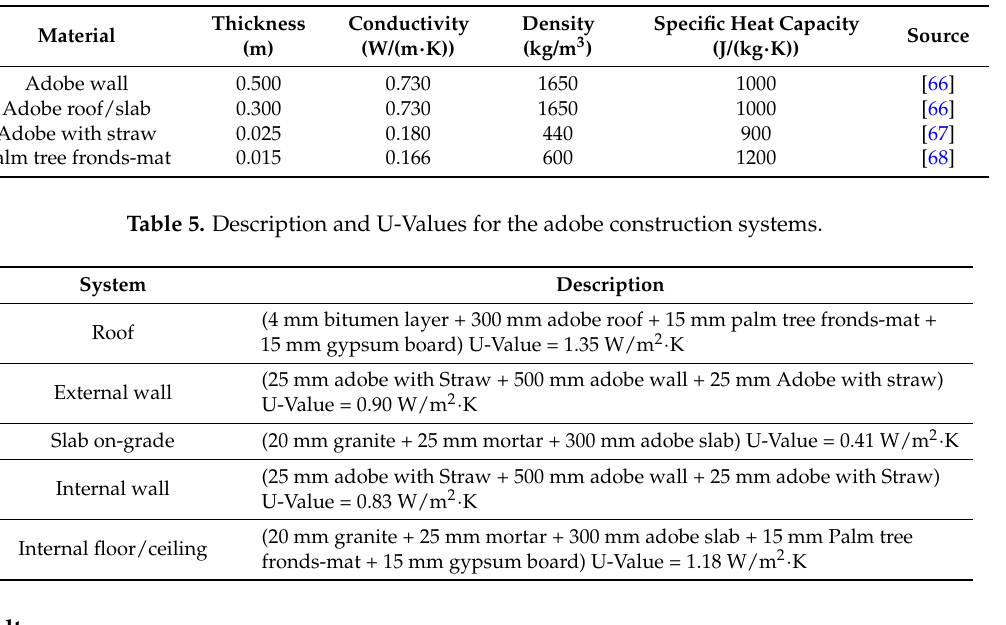
Table 4. Thermal properties of the materials used in adobe construction.